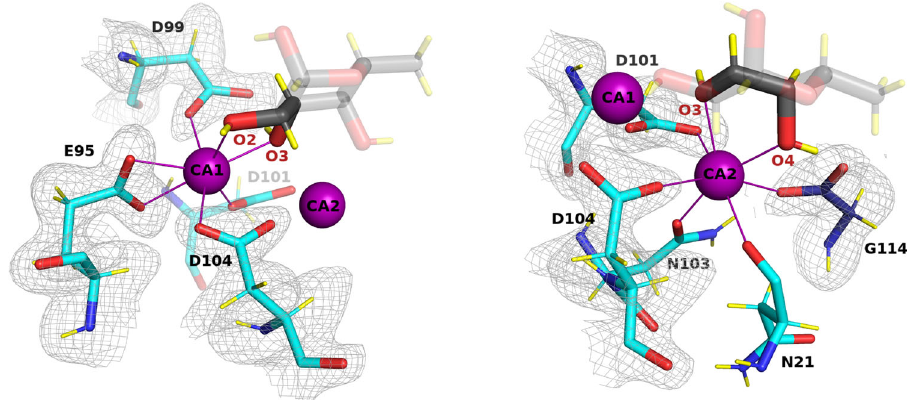
Fig. 3 Calcium ions environment and protonation state of acidic residues. The 2m F o -D F c neutron scattering length density (gray mesh) is contoured at 0.8 σ . Calcium ions are shown as purple spheres and metal coordination as solid purple lines (binding site in chain B is